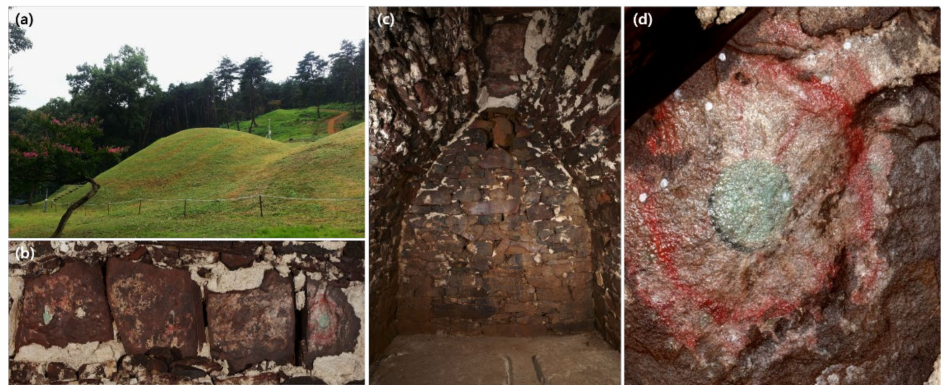
Figure 1. Overview of murals in the Goa-ri Tomb. ( a ) Outside. ( b ) Mural paintings of ceiling on burial chamber. ( c ) Status of burial chamber. ( d ) Mural painting details.